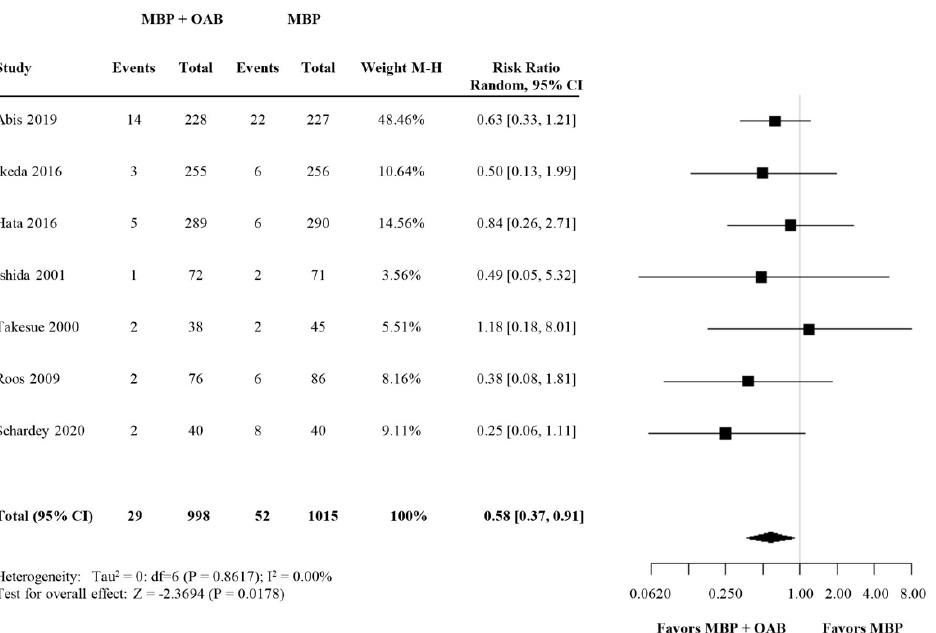
Figure 2. Forest plot comparing anastomotic leakage rate for patients receiving OABs in addition to MBP and i.v. antibiotic prophylaxis versus MBP alone with i.v. antibiotic prophylaxis. A random effects model was used to perform the meta-analysis and risk ratios are quoted including 95% confidence intervals.